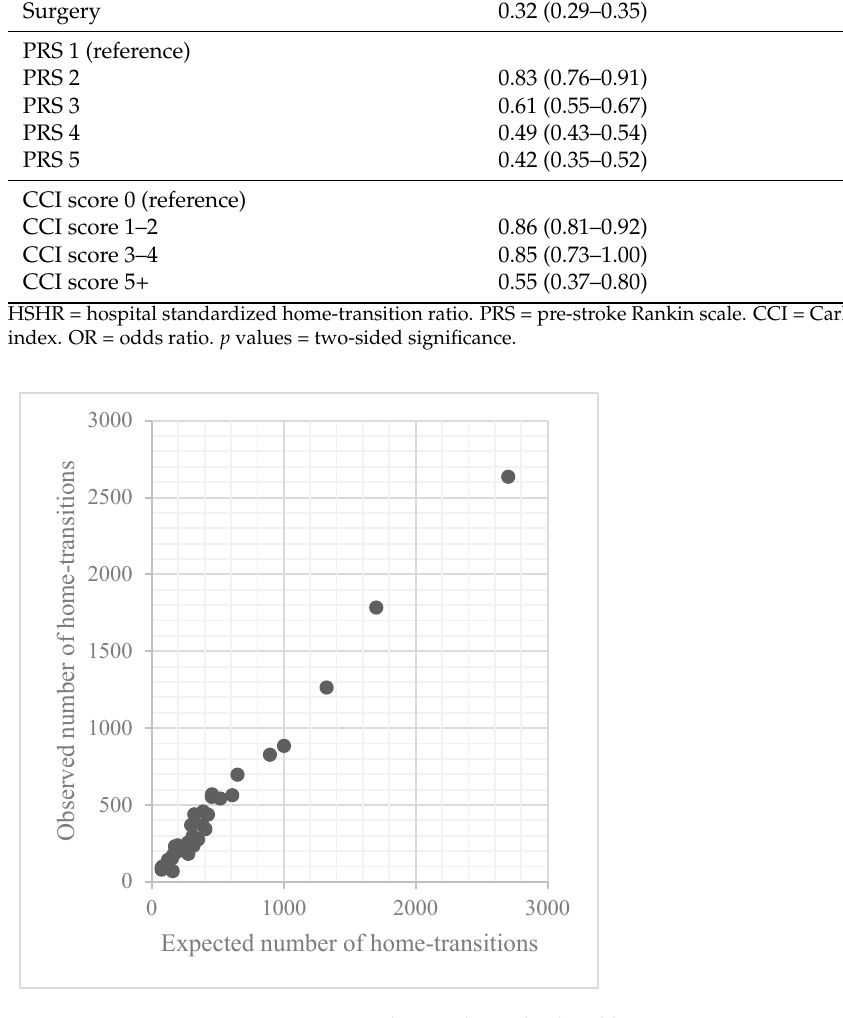
Figure 1. Variation in HSHR. HSHR = hospital standardized home-transition ratio. Table 5. Mean and SD of HSHRs.